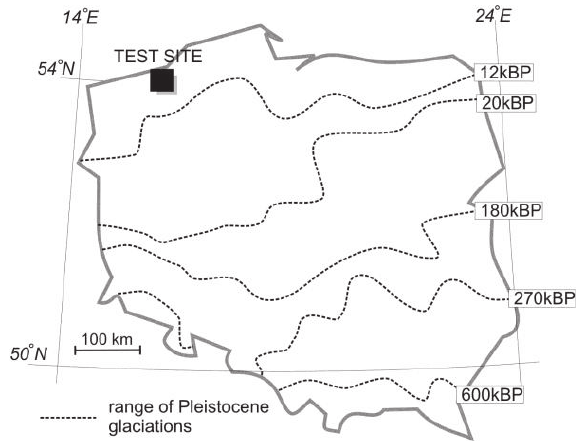
Figure 1: Location of the test site in Poland. Use of functional cluster analysis of CPTU data for assessment of subsoil rigidity model